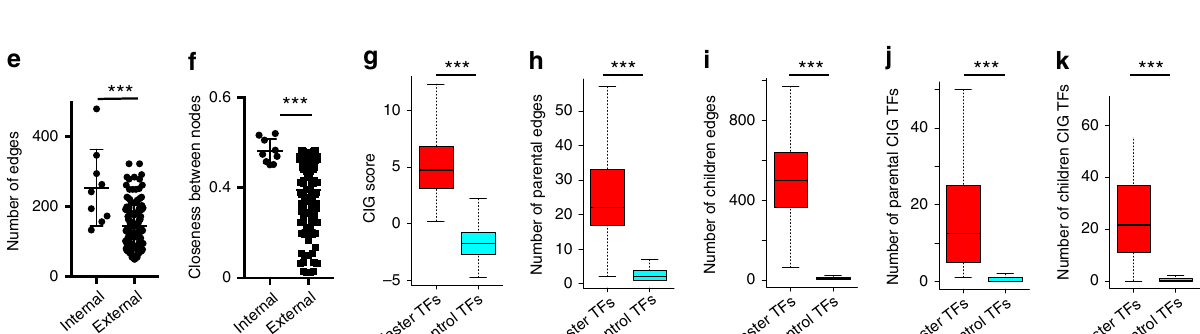
for each gene was determined by the function Cuffdiff in Cuf fl inks version 2.2.1 with default parameter values. Afterwards, quantile normalization of gene expression values was performed across cell and tissue types.